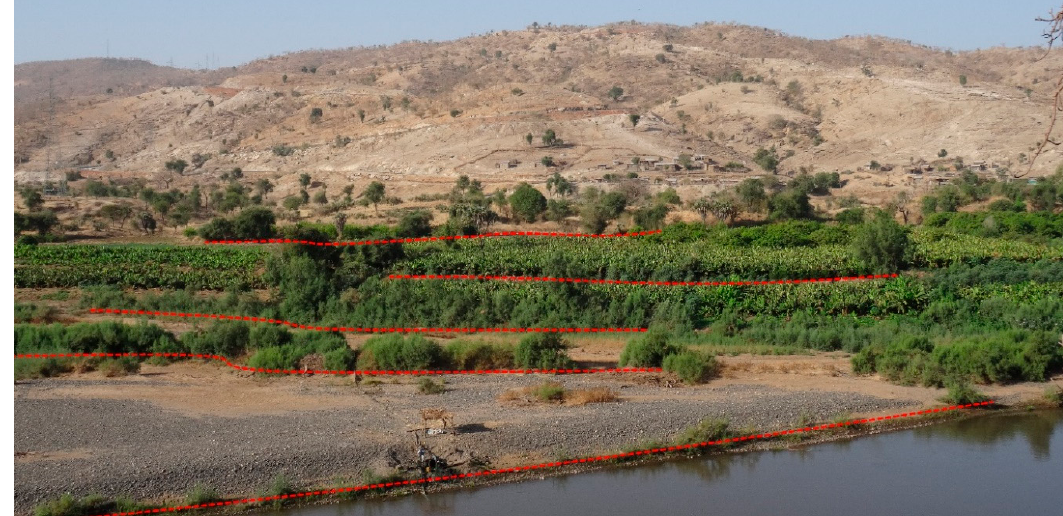
Figure 7. Five generations of Tamarix nilotica can be observed at RK208, indicated by the dotted red lines. Root crowns of the tamarisk trees and bushes typically follow the (maximum) flooded perimeter, which clearly has displaced towards the river after the Tekeze Dam became operational (Photo: 30 January